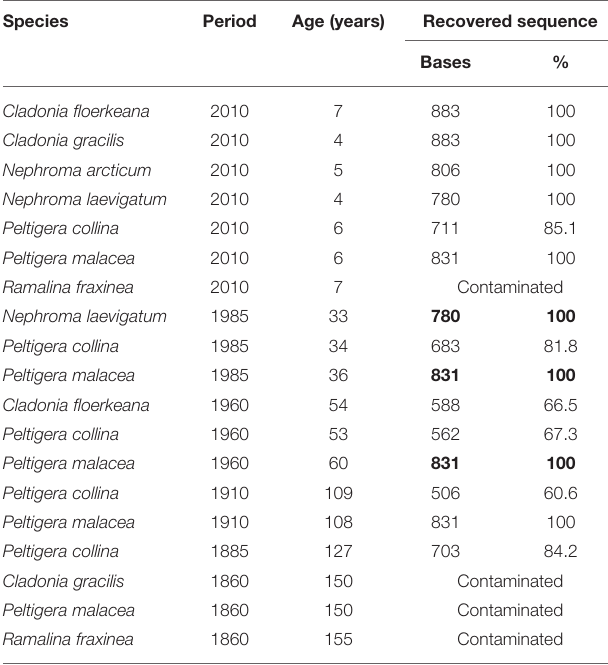
TABLE 3 | Specimens recovered with Sanger sequencing including length of